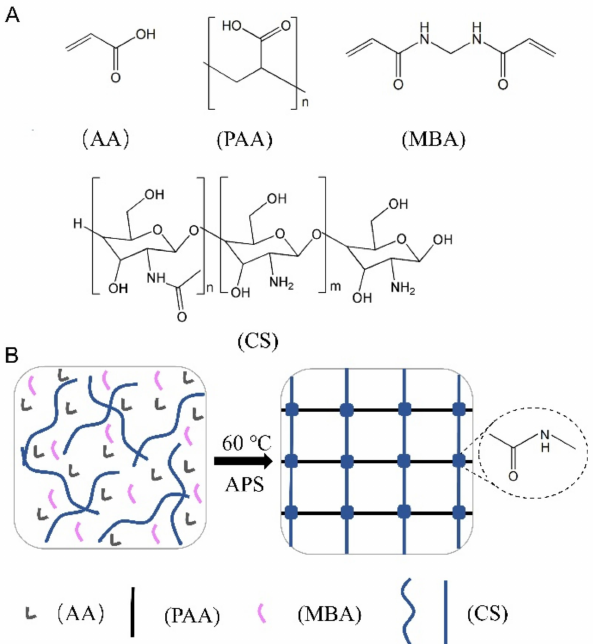
Figure 2. ( A ) Structural formulas of acrylic acid (AA), polyacrylic acid (PAA), chitosan (CS), and N, N (cid:48) -Methylenebis(acrylamide) (MBA). ( B ) Schematic diagram of the one-pot method for the synthesis of CS-based